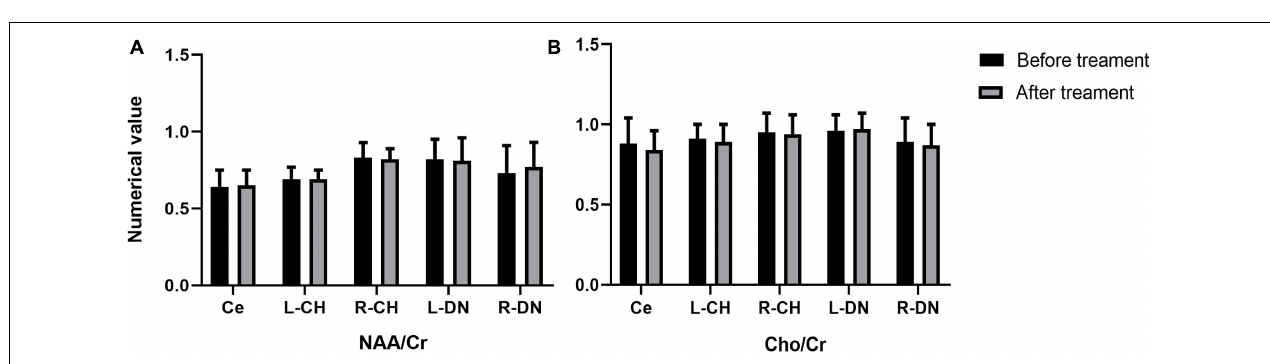
FIGURE 3 | Changes in the values of NAA / Cr (A) , and Cho / Cr (B) in cerebellar vermis, left and right cerebellar hemisphere, left and right dentate nucleus before and after treatment in the real stimulation group. (Ce representing the cerebellar vermis; L-CH representing the left cerebellar hemisphere; R-CH representing the right cerebellar hemisphere L-DN represents the left dentate nucleus; R-DN represents the right dentate nucleus). *Indicates the significant difference in the comparison between pre and post stimulation.